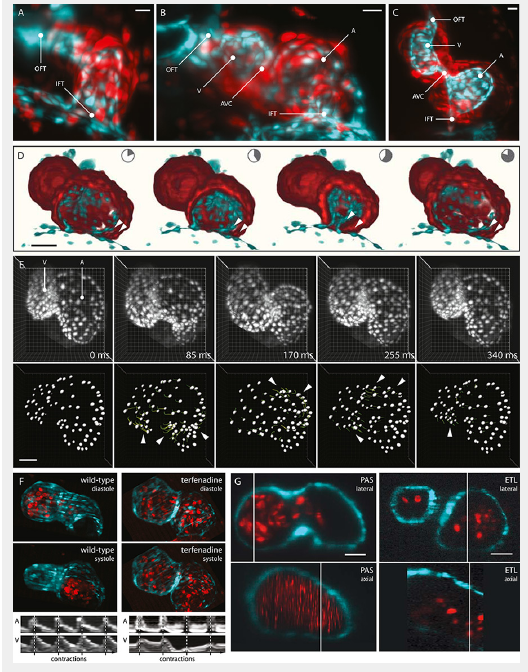
3D recordings of the embryonic zebrafish heart. A–C: Maximum intensity projections of image stacks recorded from silent hearts of 1–3 dpf transgenic Tg(kdrl:eGFP,myl7:dsRed, gata1a:dsRed) zebrafish. Inflow tract (IFT), atrium (A), atrioventricular canal (AVC), ventricle (V), outflow tract (OFT). Scale bar: 20 µm. D: 3D reconstruction of the beating heart of a 2 dpf zebrafish embryo. Cut open to reveal inflow tract and impact of cardiac jelly on pumping efficiency (arrow heads). E: 3D cell tracking in a beating zebrafish heart. 3D-projections of 2 dpf Tg(myl7:GCaMP5G-Arch(D95N), myl7:H2A-mCherry) zebrafish hearts. Postacquisition synchronisation, tracking based on segmentation of H2A-mCherry channel. Segmented cardiomyocytes with partial tracks (dragon tails, colour-coded for velocity). Areas of fastest contraction highlighted (arrow heads). F: Wild-type and arrhythmic hearts of 2 dpf transgenic Tg(myl7:GFP, GATA1:dsRed) zebrafish. Maximum intensity projections of rapid volume scanning image data. Arrhythmia induced by treatment with terfenadine. Kymographs of atrial and ventricular contractions. Ventricular contractions are absent in several cycles of the terfenadine-treated hearts. G: Comparison of 3D image data generated with postacquisition synchronisation (PAS) and rapid volume scanning (ETL). Hearts of 2 dpf of transgenic Tg(myl7:GFP, GATA1:dsRed) zebrafish. 3D blood cells are only visible in ETL data. Scale bar: 20